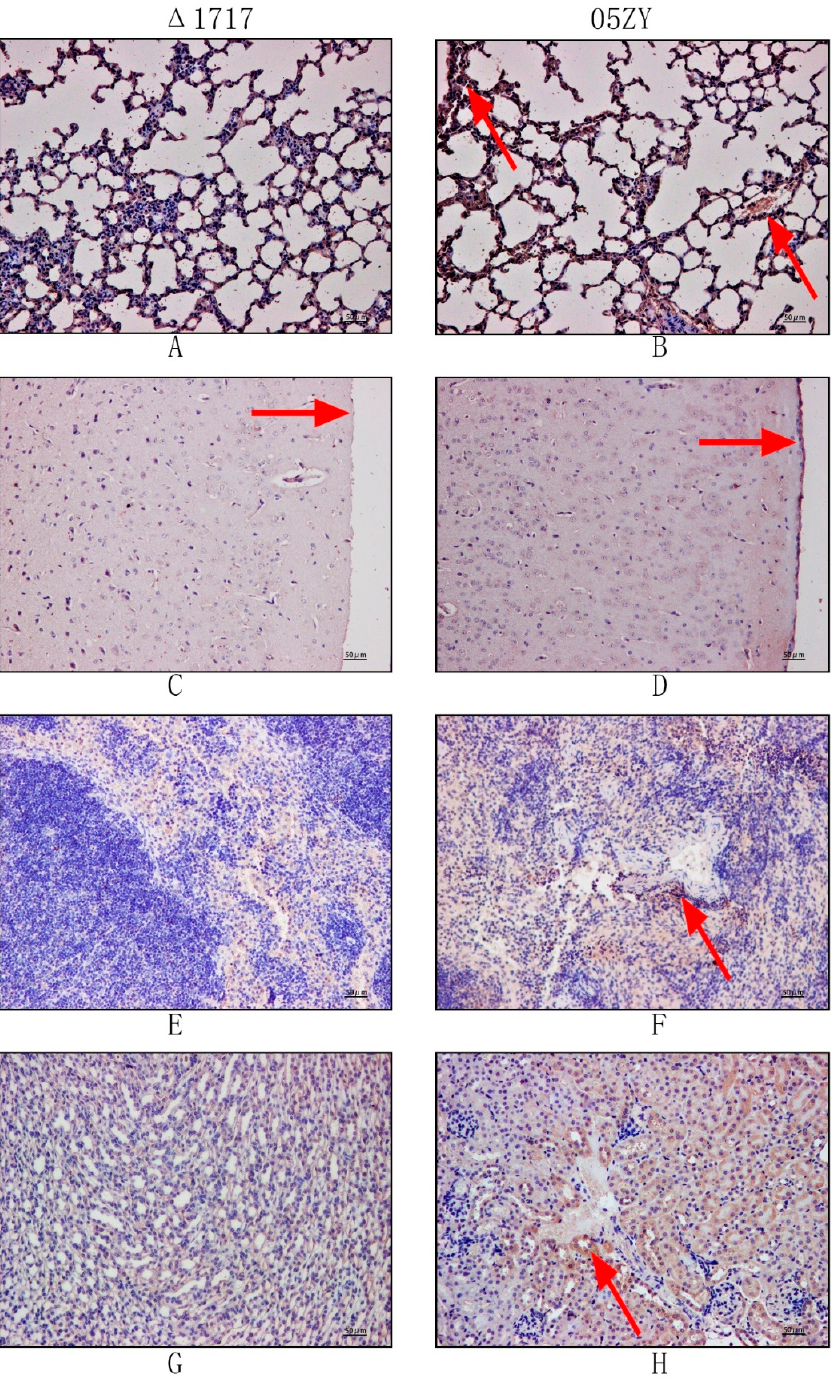
Figure 9. Immunohistochemistry of mouse organs after ∆ 1717 or 05ZY infection: 10 out of 30 (the remaining 20 were used for mice infection see Figure 8A) four-week-old male C57BL / 6 mice were randomly divided into two groups, with 5 mice in each group. One group was intraperitoneally infected with 6 × 10 8 CFU of 05ZY, and the other group was given an equal quantity of ∆ 1717. After 6 h, 5 mice in each group were sacrificed. The lungs, kidneys, spleens, and brains were extracted, fixed with paraformaldehyde for immunohistochemistry. The rehabilitation serum of pigs infected with 05ZY was used as the primary antibody for immunohistochemistry (1:300), and HRP Goat Anti-Swine IgG (H + L) was used as the secondary antibody (1:200) (Abclonal, Wuhan, China). ( A , B ) lungs; ( C , D ) meninges; ( E , F ) spleens; ( G , H ) kidney.